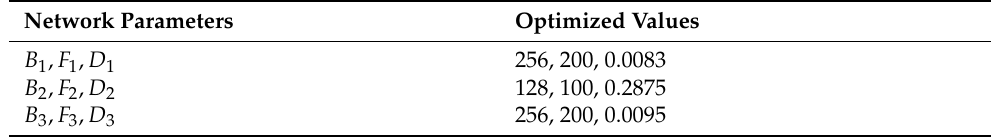
Table 6. Average ACC percentages of the three approaches for the varying window